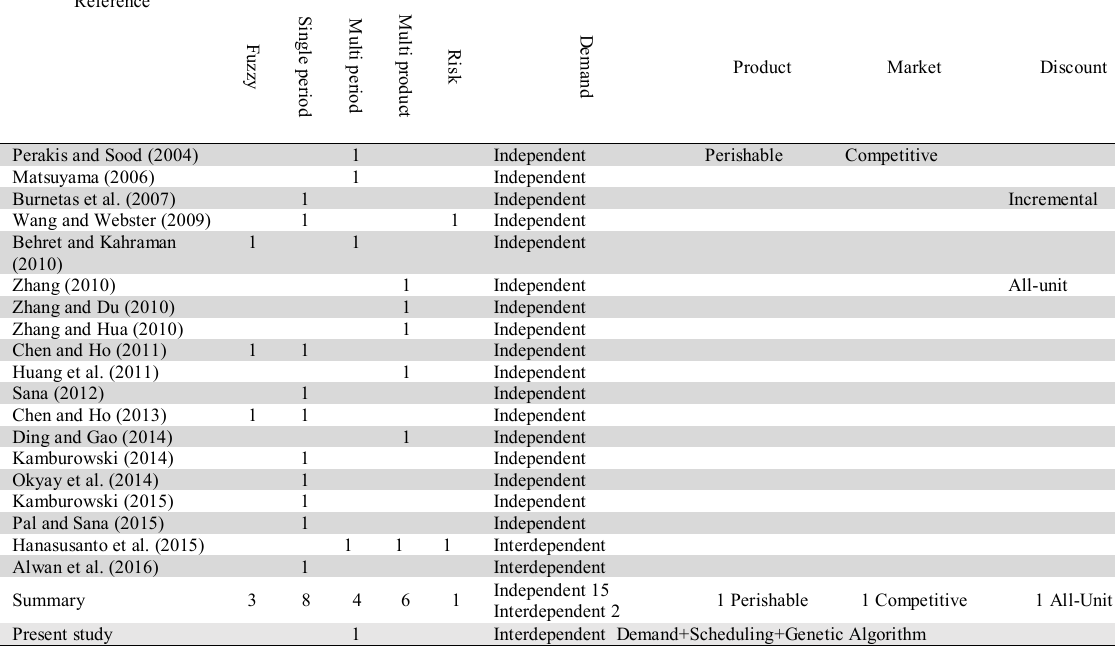
Classification of the literature.